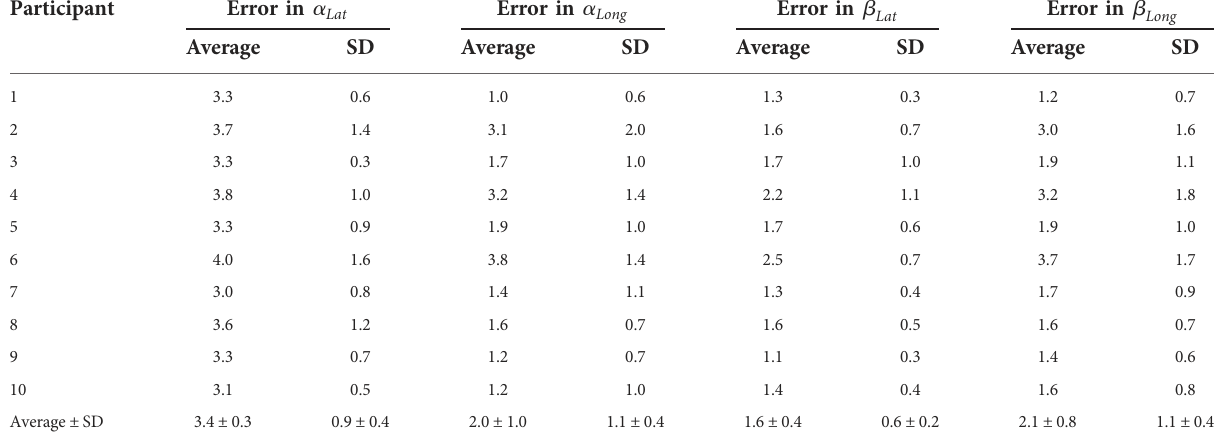
TABLE 2 Errors from manually measured four points in the IMU sensor (unit: °). Participant Error in a